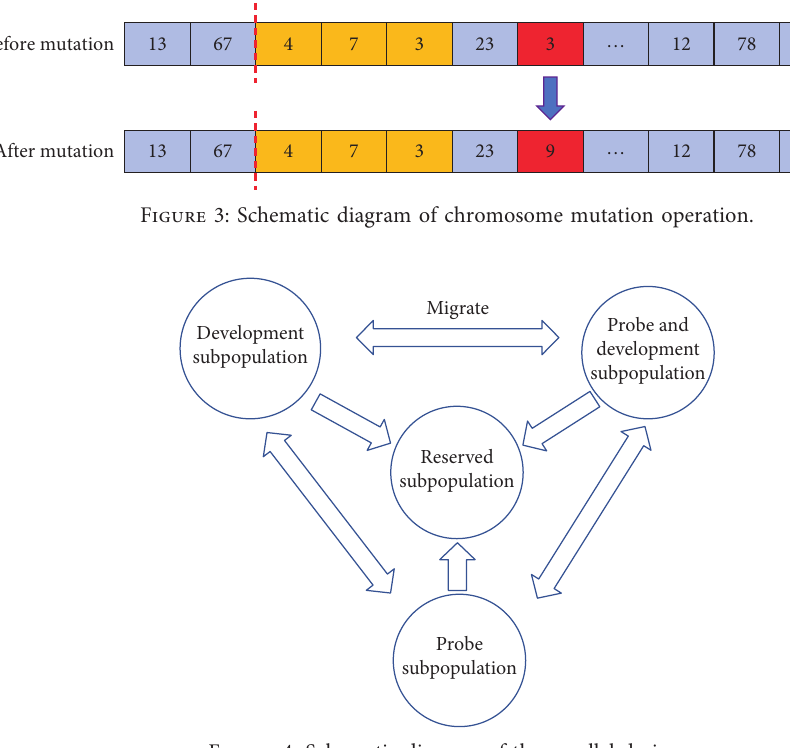
Figure 4: Schematic diagram of the parallel design.